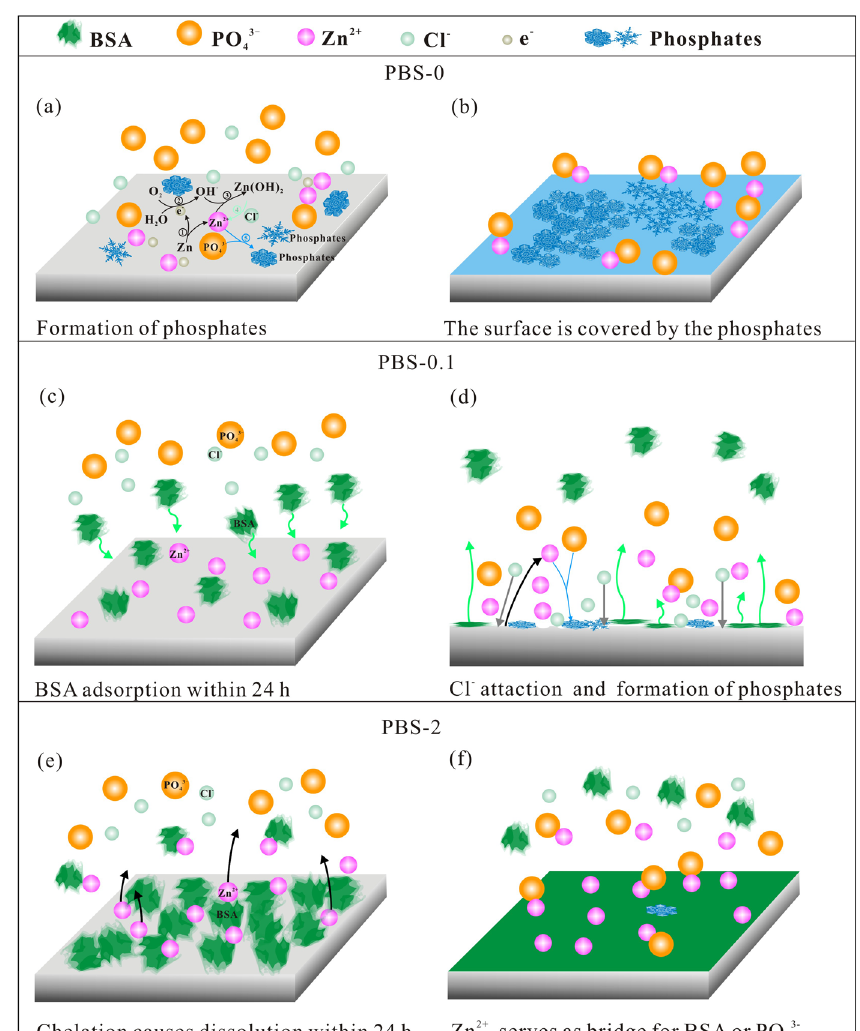
Fig. 7 Schematic illustration of interfacial reactions of PBS/BSA and pure Zn surface. a, b The process of zinc phosphates formation in the PBS-0; c, d initial BSA adsorption and later formation of phosphates in the PBS-0.1; e, f chelation of BSA and zinc causes release of Zn, then Zn 2 + attracts BSA as well as PO